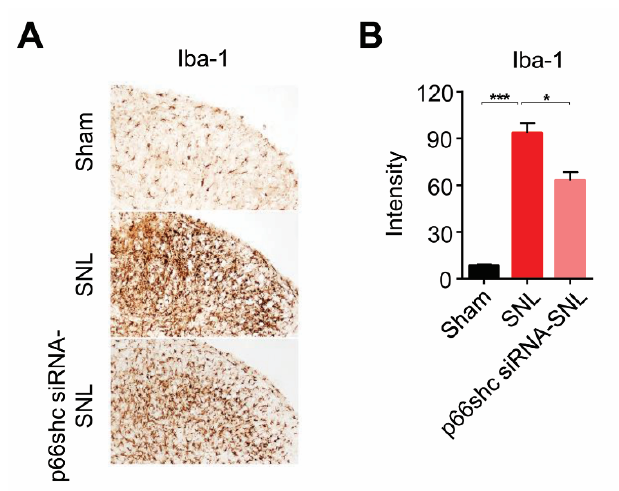
Figure 4. Iba-1 immunoreactivity in the ipsilateral spinal cord at seven days after SNL. ( A ) microglial